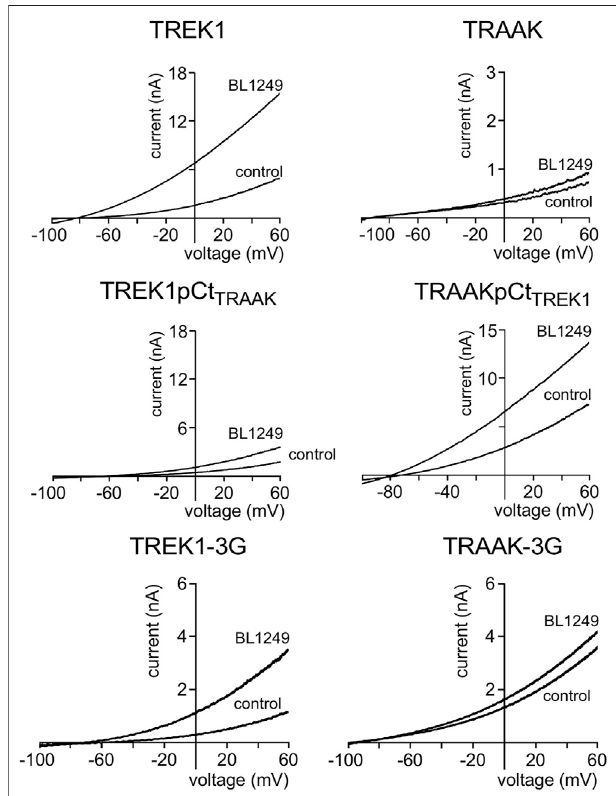
FIGURE3| ProximalC-terdomain(pCt)modulateschannelsensitivityto drugs. Representative patch-clamp recordings from HEK cells expressing